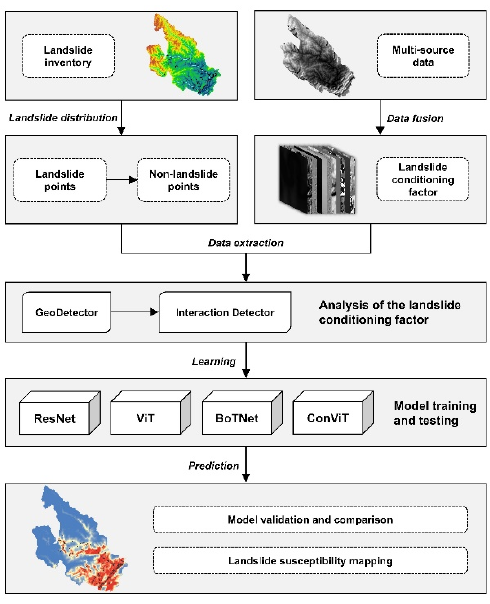
Figure 7. Flow chart of this study.